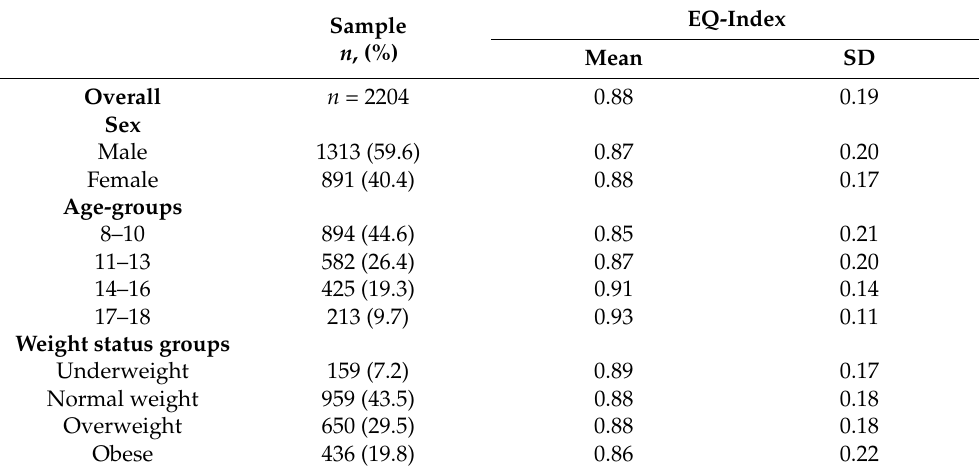
Table 1. Participant